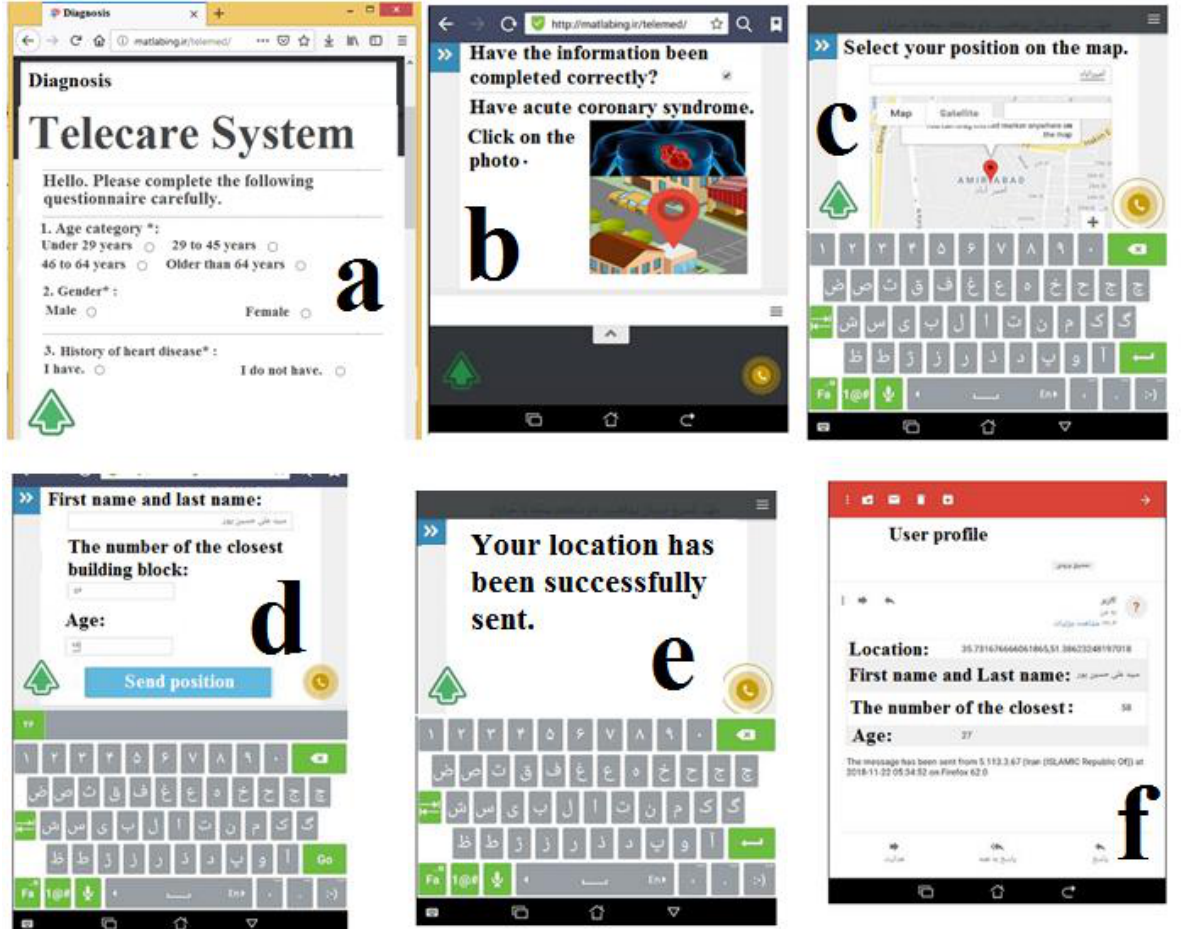
Figure 7. Some screenshots of prototype system at the time of sending information to the support system. a) By searching the http://matlabing.ir/telemed in the browser, the designed system will be displayed. A web page displays a questionnaire to the user. The user has entered the information and the system detected that the user is ill. b) The result of the diagnosis is shown to